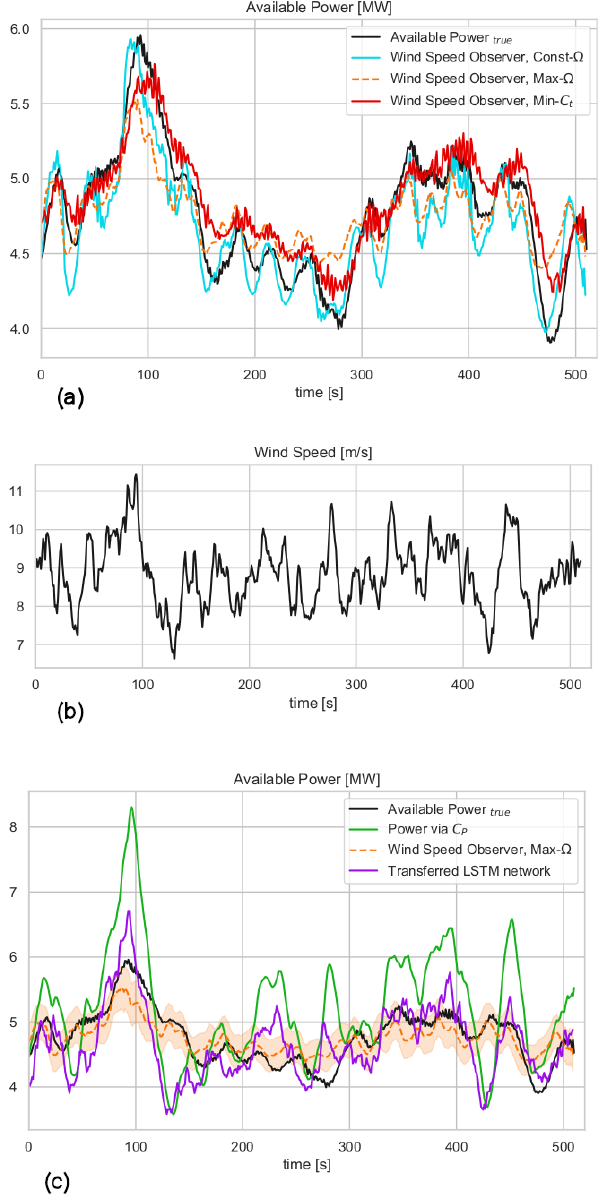
Figure 10. The 1Hz time series comparison of available power of DTU 10MW turbine, estimated by (a) the wind speed observer for the 40% down-regulation case under three different curtailment strategies; see Sect. 2. (b) Second-wise wind speed time series of the considered test case with mean wind speed = 9ms − 1 and mean TI = 10%. (c) The comparison of the available power estimated via wind speed observer following the maximum rotational speed con- trol strategy and LSTM network with transfer learning from the lower wind speed to higher wind speed cases and direct C P ap- proach. The shaded area corresponds to the effects of ± 5% over- and underestimation of C P during curtailment for WSO results. The LSTM network has no dependency on level of curtailment or esti- mation of operational C P